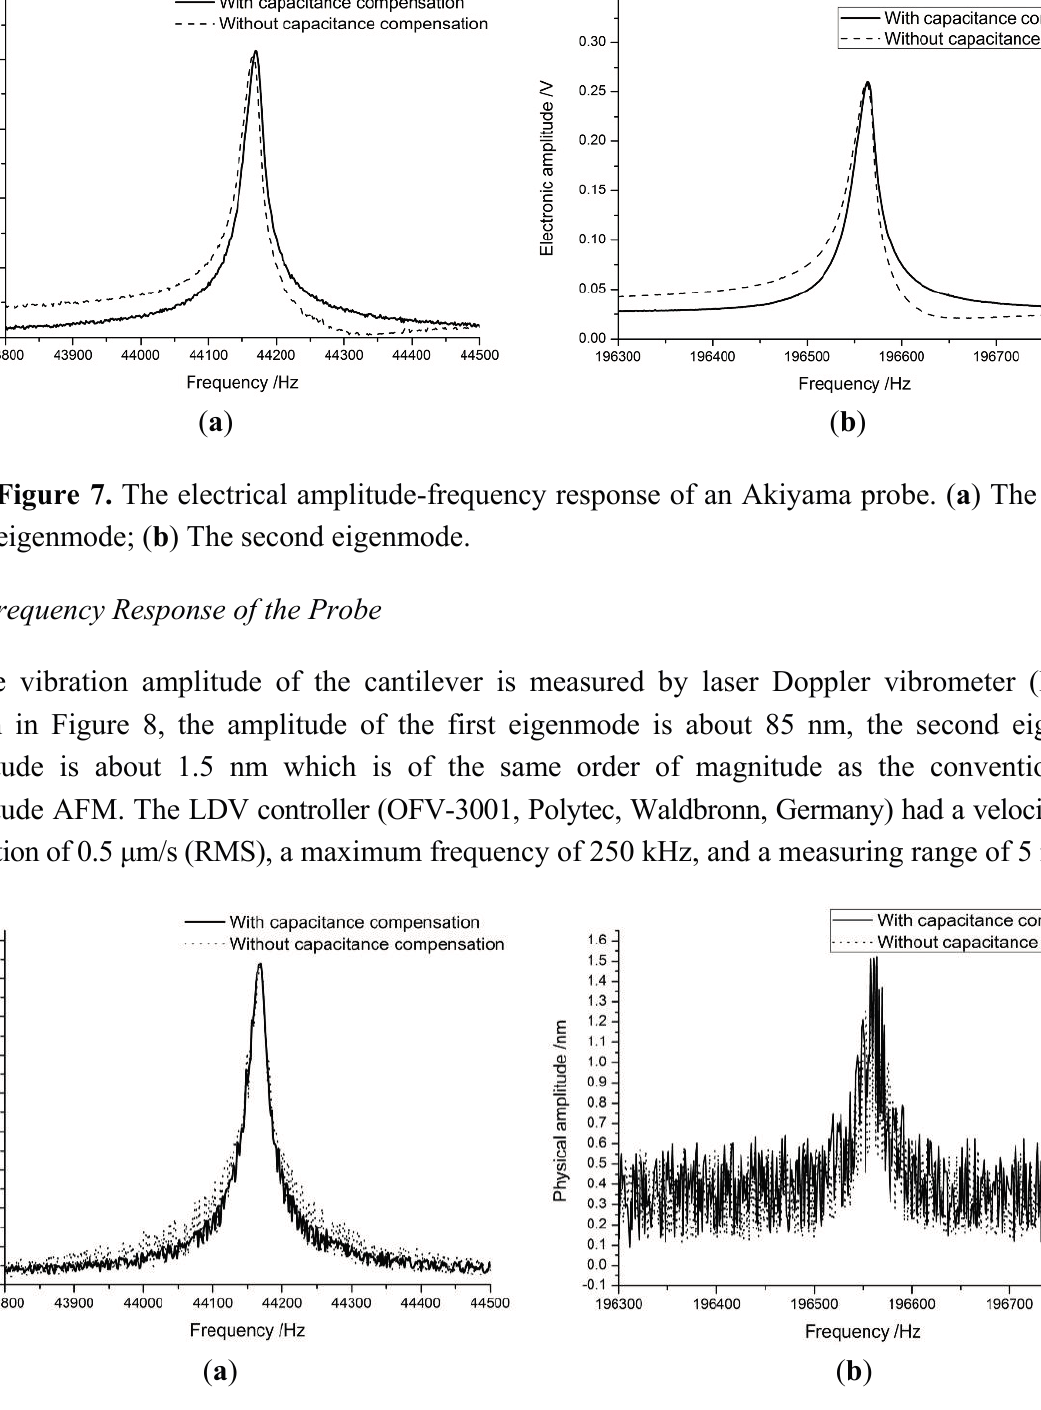
Figure 8. The vibration amplitude-frequency response of an Akiyama probe. ( a ) The first eigenmode; ( b ) The second